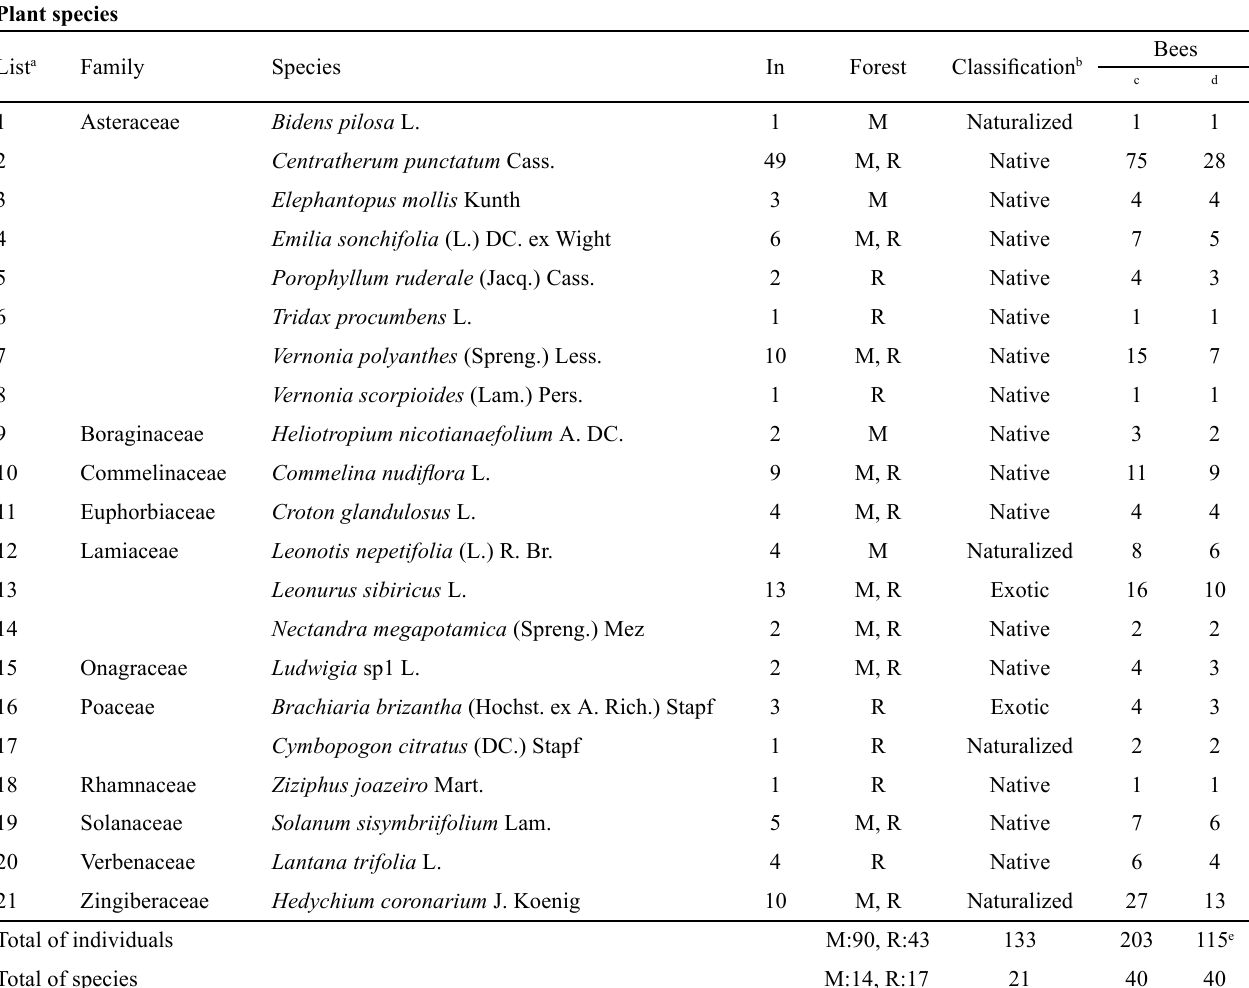
Table 2 . Plant species: native, naturalized and exotic sampled in the mature and regenerating forest fragment of the Atlantic Forest, Paraná, southern